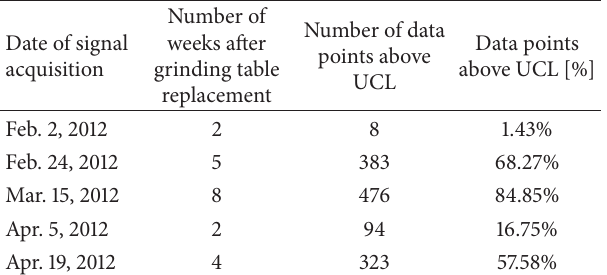
Table 2: Number of data points above the upper control limit.